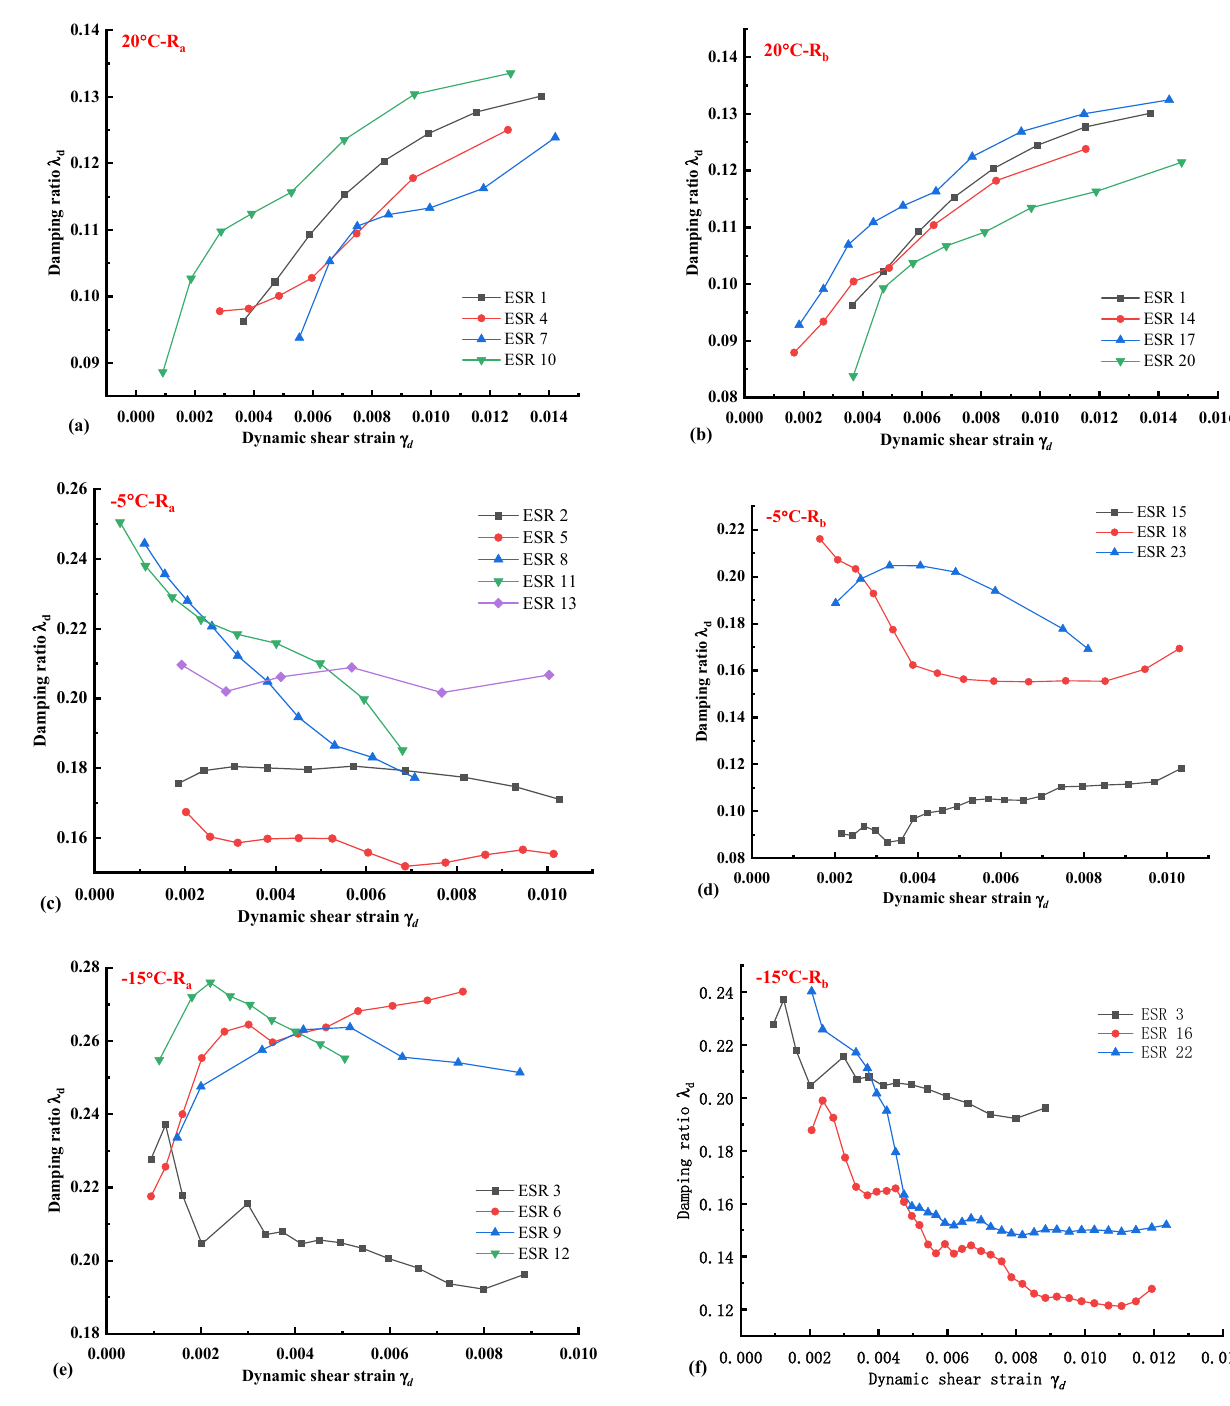
Figure 10. Damping ratio of expansive soil under different rubber forms and yields. ( a ) 20 ◦ C R a specimens. ( b ) 20 ◦ C R b specimens. ( c ) − 5 ◦ C R a specimens. ( d ) − 5 ◦ C R b specimens. ( e ) − 15 ◦ C R a specimens. ( f ) − 15 ◦ C R b